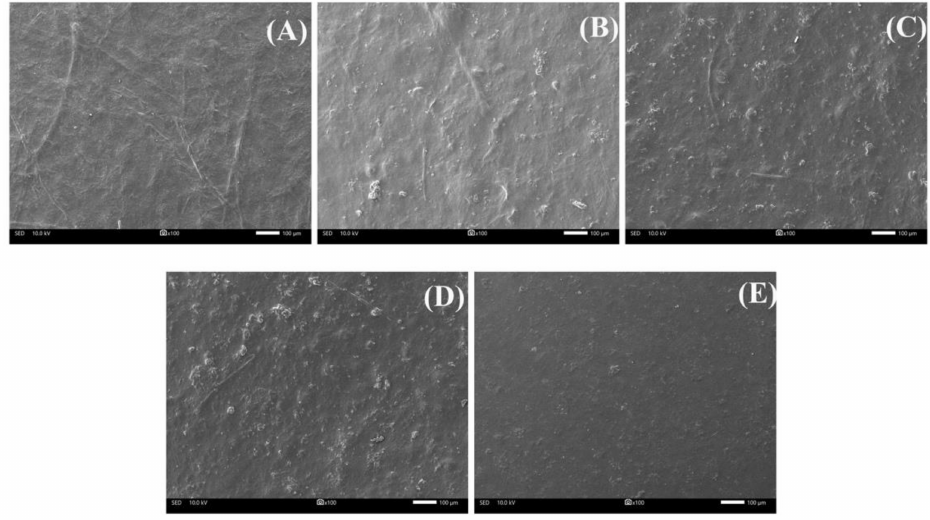
Figure 6. SEM micrograph surface of ( A ) CMCy film, ( B ) CMCy75/RF25 composite film, ( C ) CMCy50/RF50 composite film, ( D ) CMCy25/RF75 composite film, and ( E ) RF